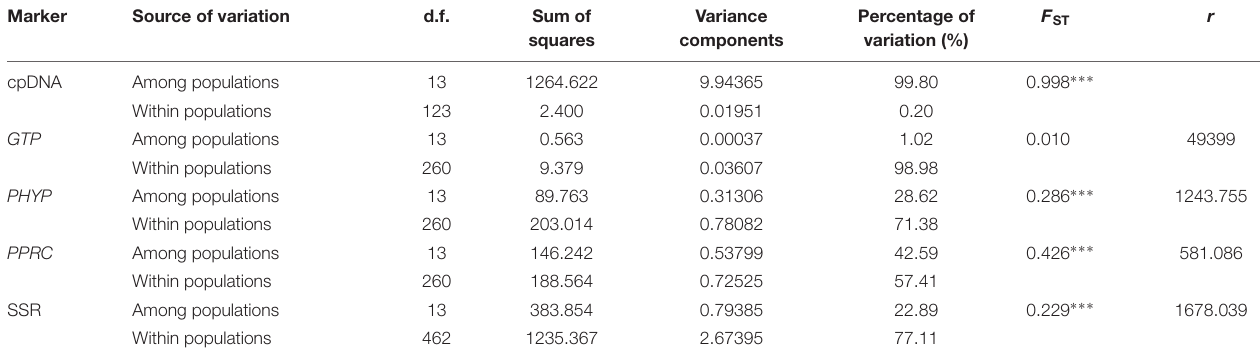
TABLE 1 | Analysis of molecular variance (AMOVA) based on DNA sequences and microsatellites for populations of C. segmentifida . Marker Source of variation d.f. Sum of